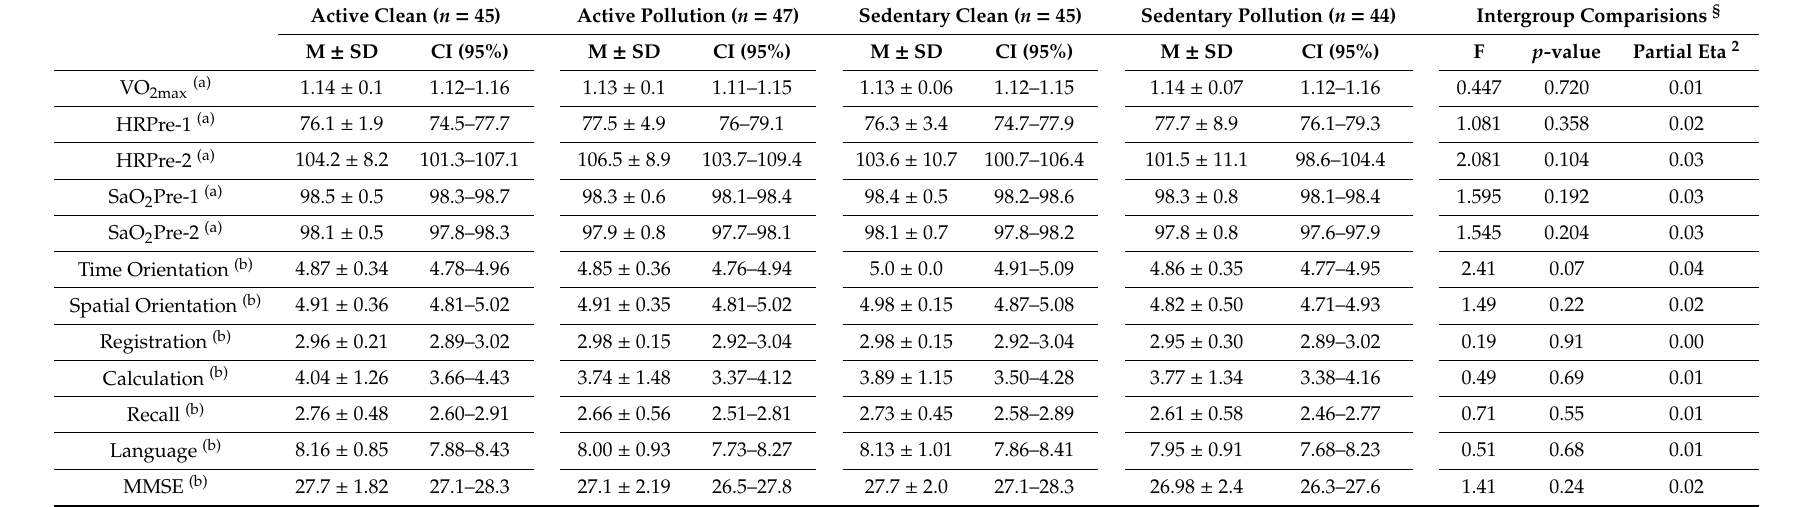
Table 3. Intergroup comparisons pretest